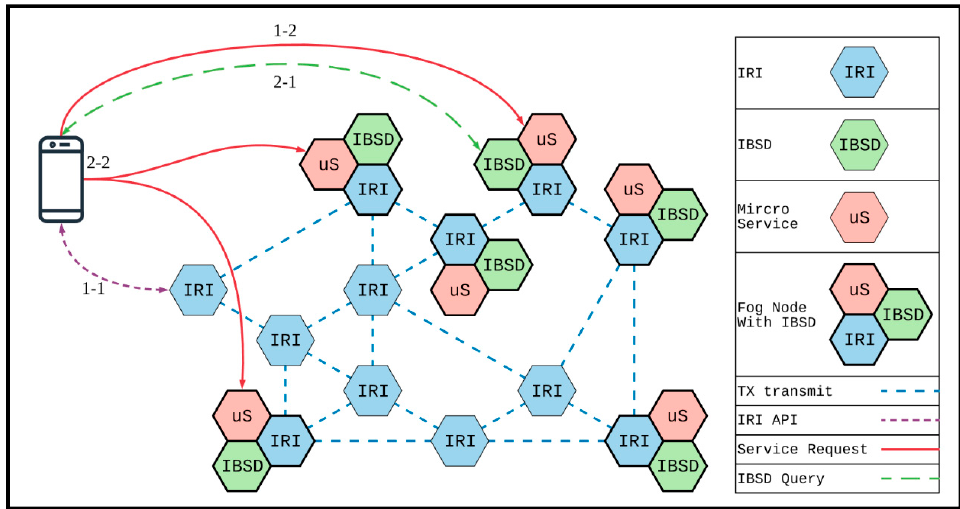
Figure 10. Execution flow of service discovery .